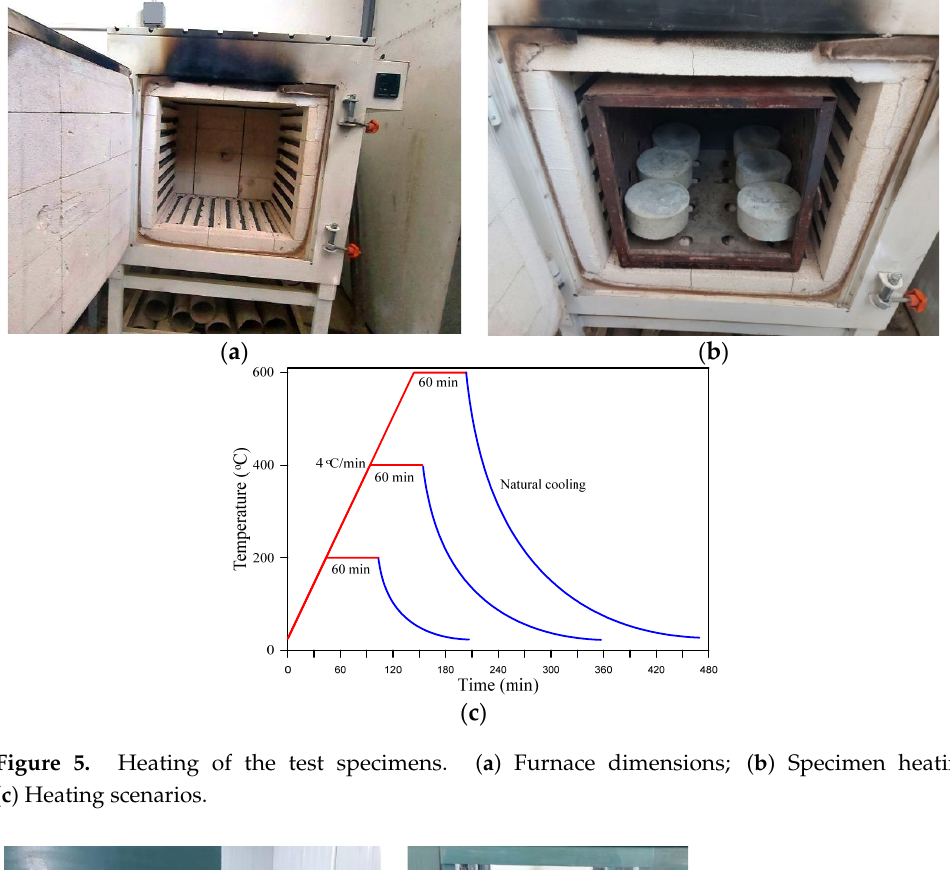
Figure 5. Heating of the test specimens. ( a ) Furnace dimensions; ( b ) Specimen heating; ( c ) Heating scenarios.